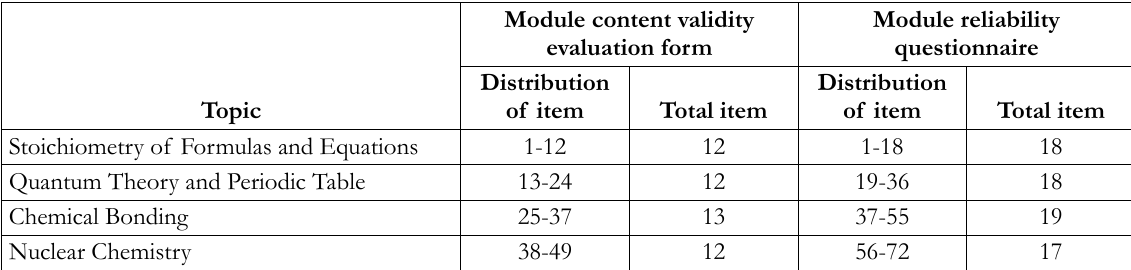
Table 4. Distribution of items in the module content validity evaluation form and module reliability questionnaire